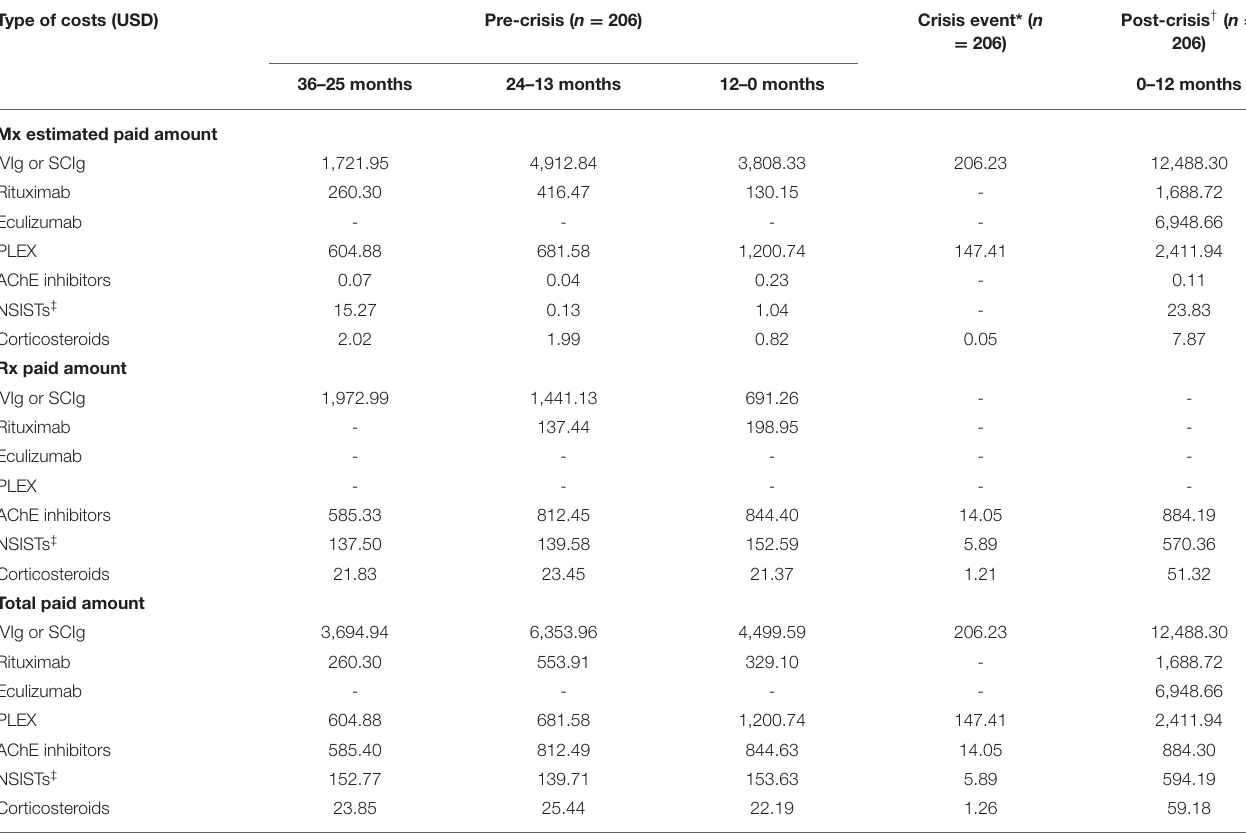
TABLE 9 | Standardized mean 12-month payer-relevant drug costs per patient in the crisis event